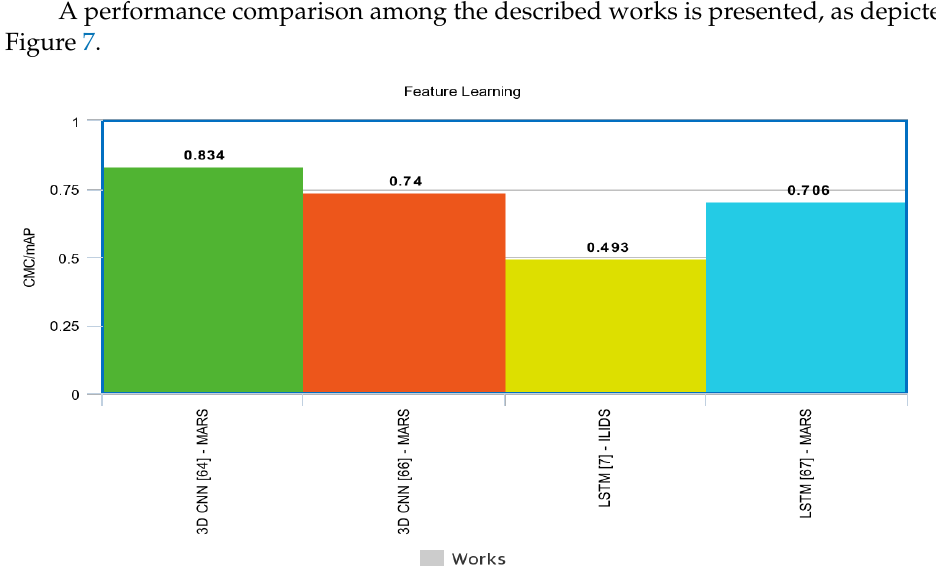
Figure 7. Performance summary of the evaluated sequence model